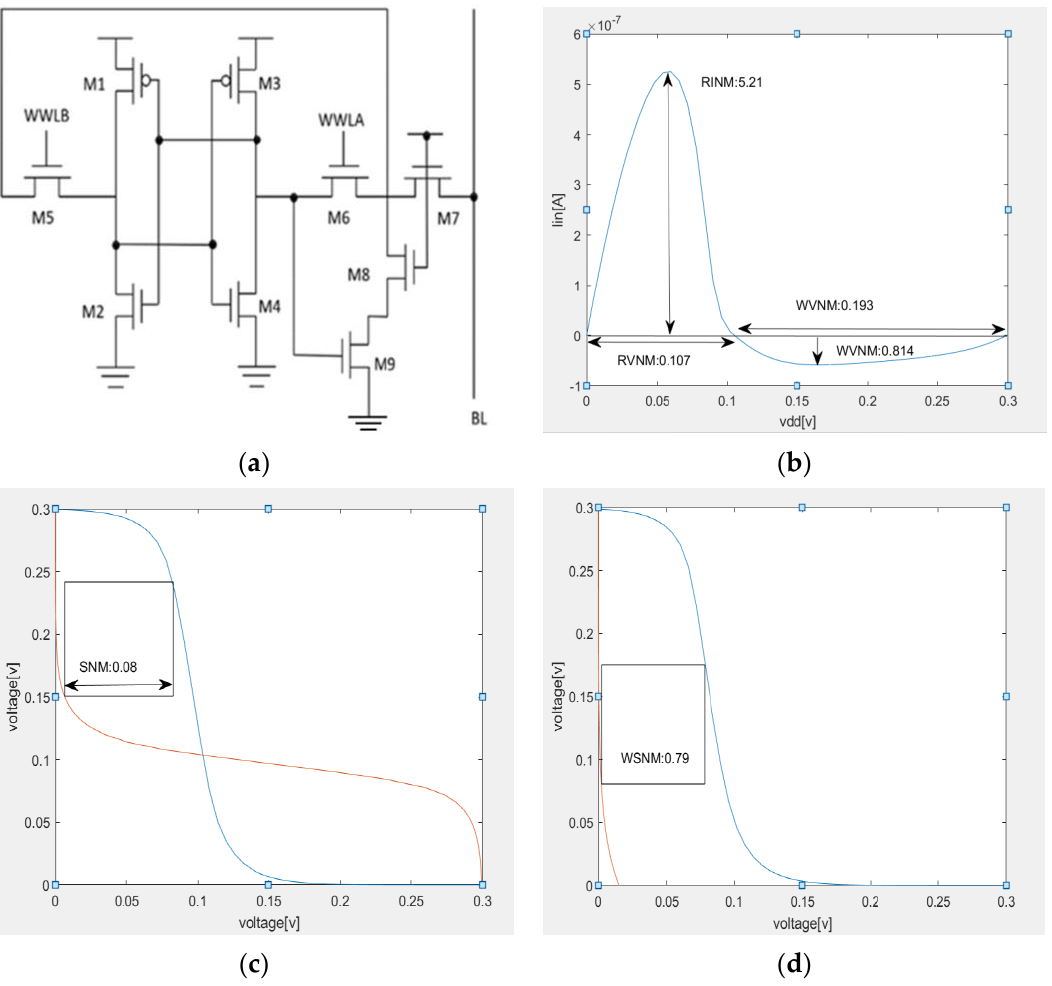
Figure 11. ( a ) 9T unit schematic; ( b ) stability based on leakage current; ( c ) read static stability; and ( d ) write static stability.